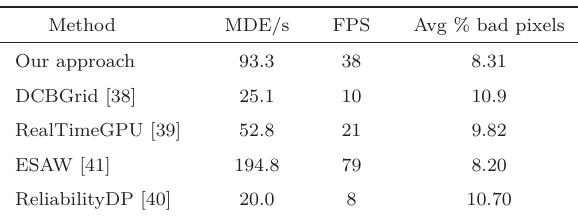
Table 6 Comparison of accuracy and speed for real-time methods Table 7 Accuracy and speed for MV3